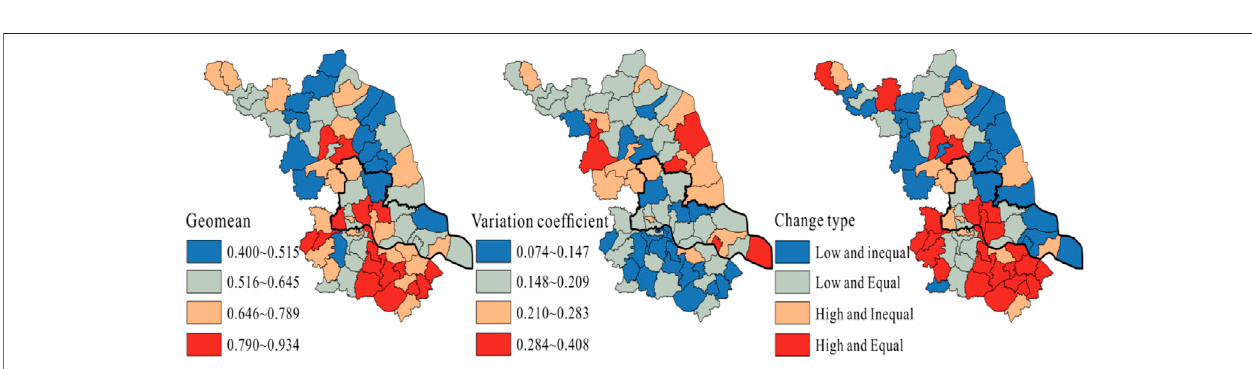
FIGURE 4 | Spatial evolution pattern of regional agricultural eco-ef fi ciency.